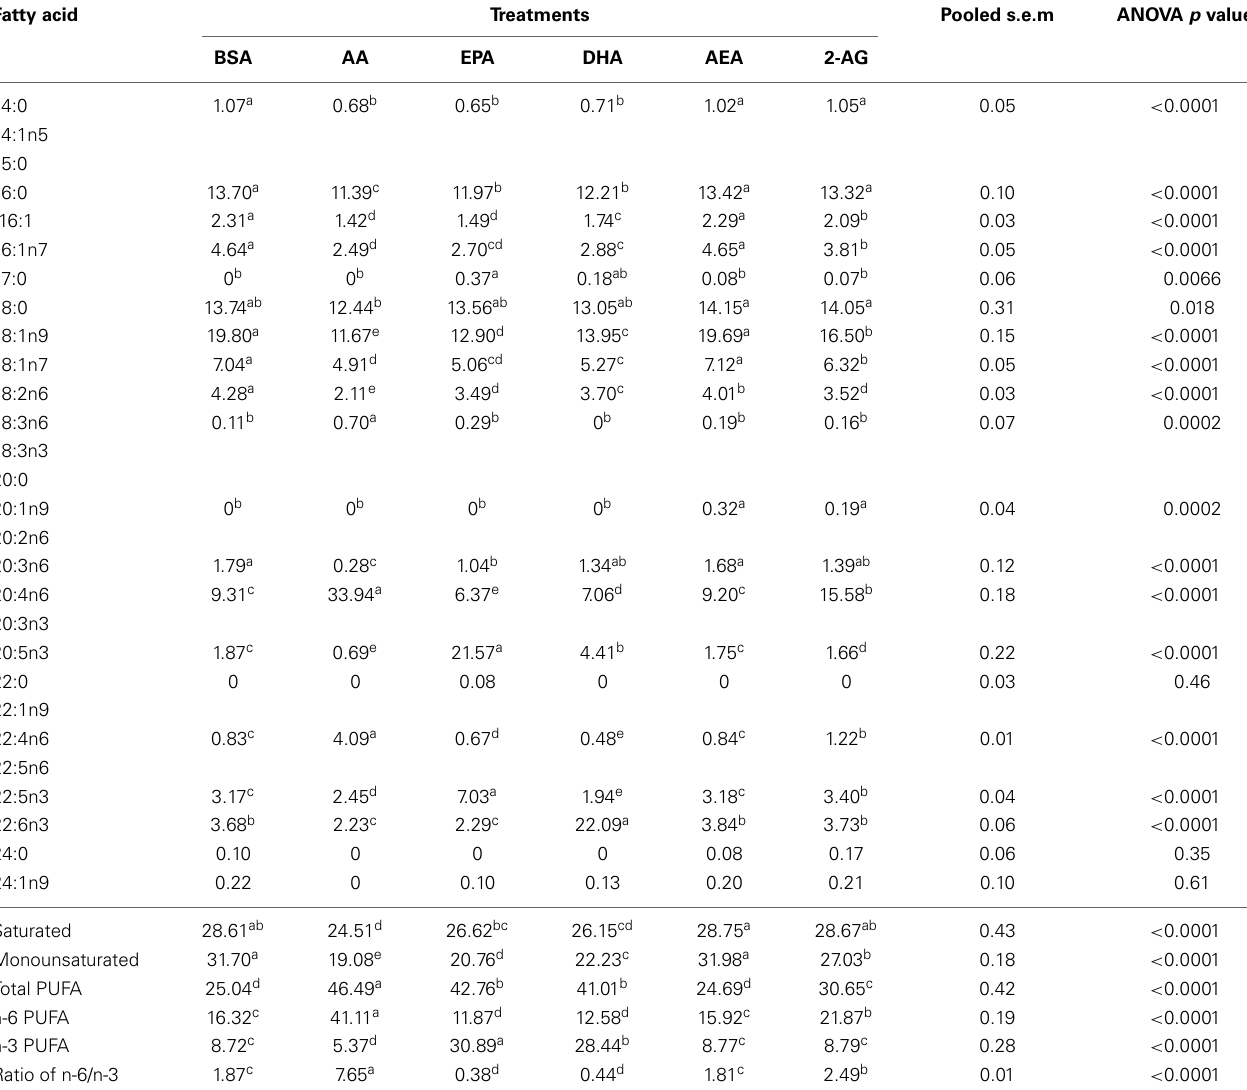
Table 2 | Fatty acid composition of total lipids from differentiated C2C12 cell cultures. Fatty acid Treatments Pooled s.e.m ANOVA p